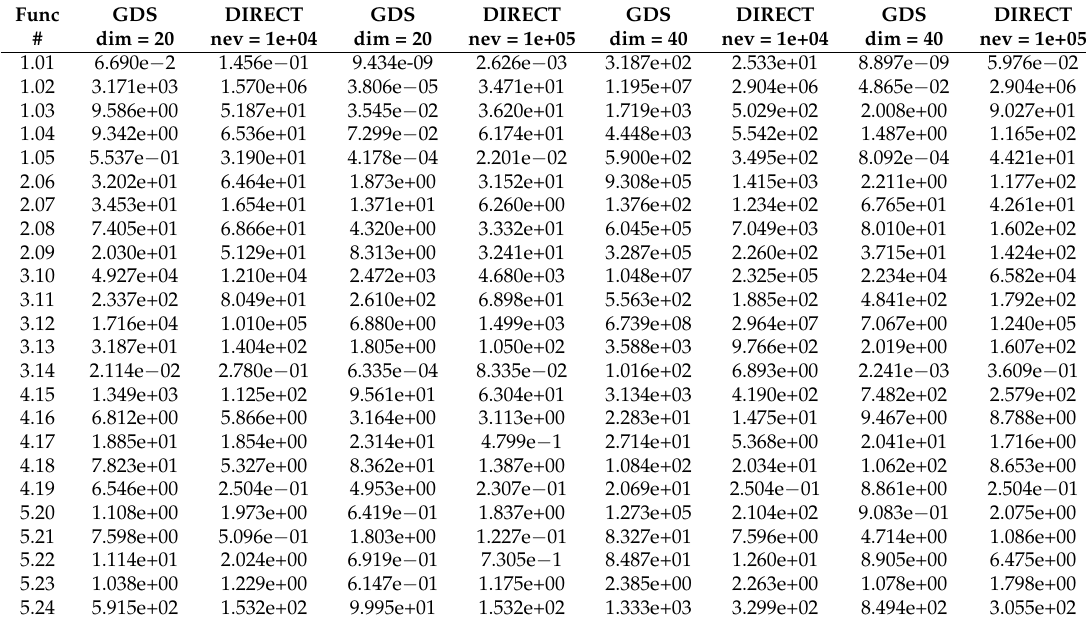
Table 3. Comparative study of the median of the error for problems of dimensions 20 and 40 and the number of evaluations 1e + 04 and 1e + 05.